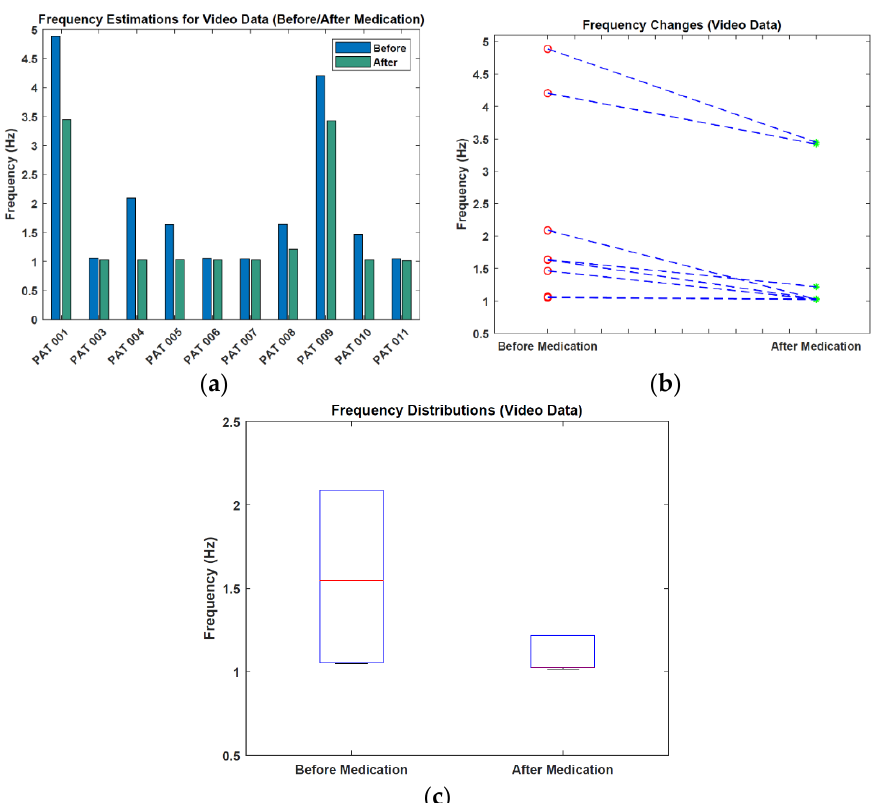
Figure 9. Visualization of the frequency results. ( a ) Frequency estimations. ( b ) Frequency changes. ( c ) Frequency distributions (values > 3 Hz are not shown).